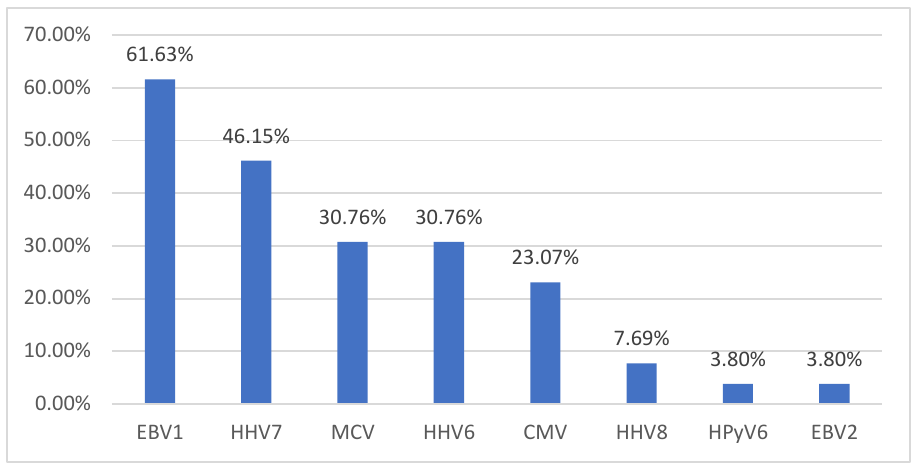
Figure 1. The prevalence of tested viruses in tumor samples.